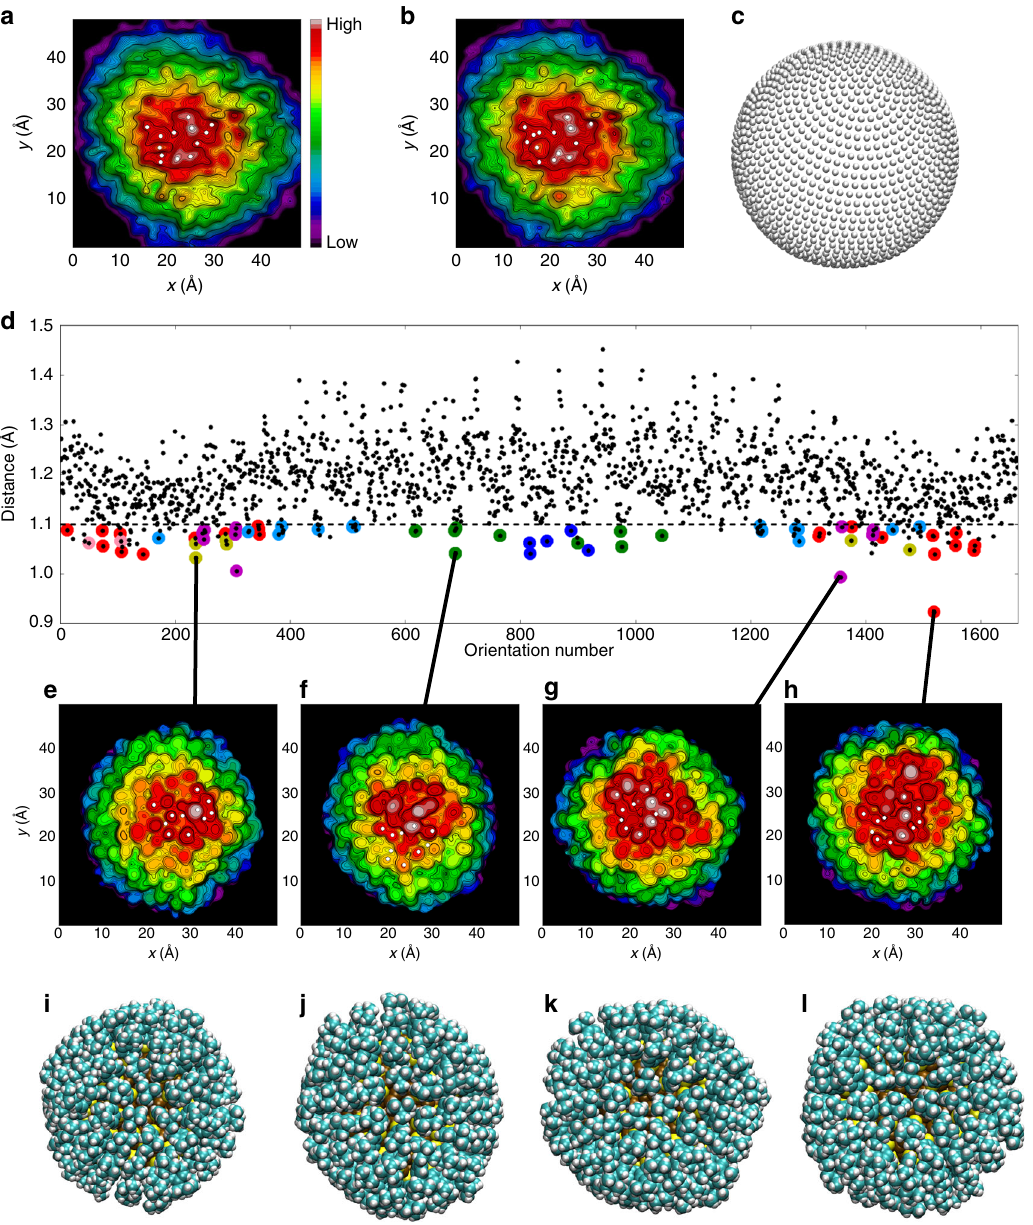
Fig. 4 “ Facial recognition ” of experimental STM topography by an automated matching of simulated images. a , b Two consecutive scans (trace and retrace) of the same Ag 374 cluster at LHe temperature (bias voltage: − 1.2 V, current: 10 pA). The white dots represent the extrema of the data. c Visualization of the set of perspectives used to prepare the simulated STM image from the computational data. Each dot corresponds to a perspective when the cluster lies at the center of the sphere. d Minimum correlation distances for each perspective, resulting from comparison to the extremum points of a .The dashed line is drawn below the major feature formed by the data points. Below this threshold, the data points with the same color correspond to a perspective very close to each other that consequently give relatively small correlation distances. Selected small-distance perspectives are connected with lines to the respective calculated STM images ( e – h ) with white dots showing the extrema. i – l The atomistic models of the cluster in similar orientations to e – h , respectively. X – Y scales are the same in experimental and simulated images, and are shown in Å. The STM simulations were done for the voltage and current values used in the the topography remained stable showing that sub-molecular resolution could be achieved. sity of electronic states of Ag 374 to 1665 different space orienta- tions (Fig. 4c), we calculated 1665 simulated topography images and compared them to experimental data (Fig. 4a), looking for Pattern recognition between experimental and simulated topographies . The sub-molecular resolution in the experimental topography data encouraged us to go one step further in com- parison between experiment and theory, by applying an idea of